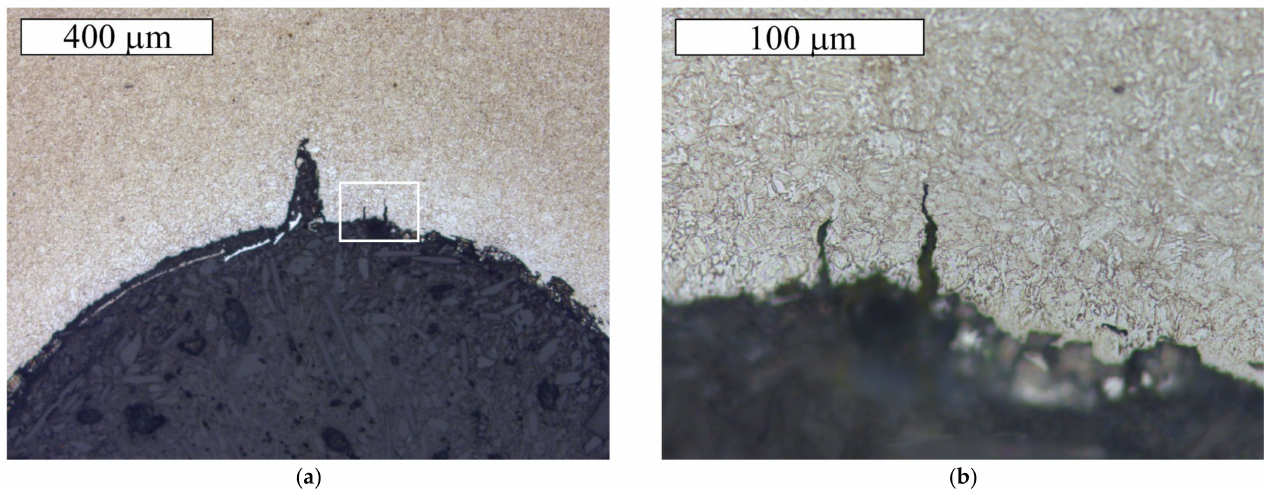
Figure 9. The longitudinal section of the threaded part of the S1 bolt. ( a ) Visible cracks initiated in the thread root, ( b ) The enlarged area indicated by the frame at the Figure 9a Etched state, Light Microscopy.